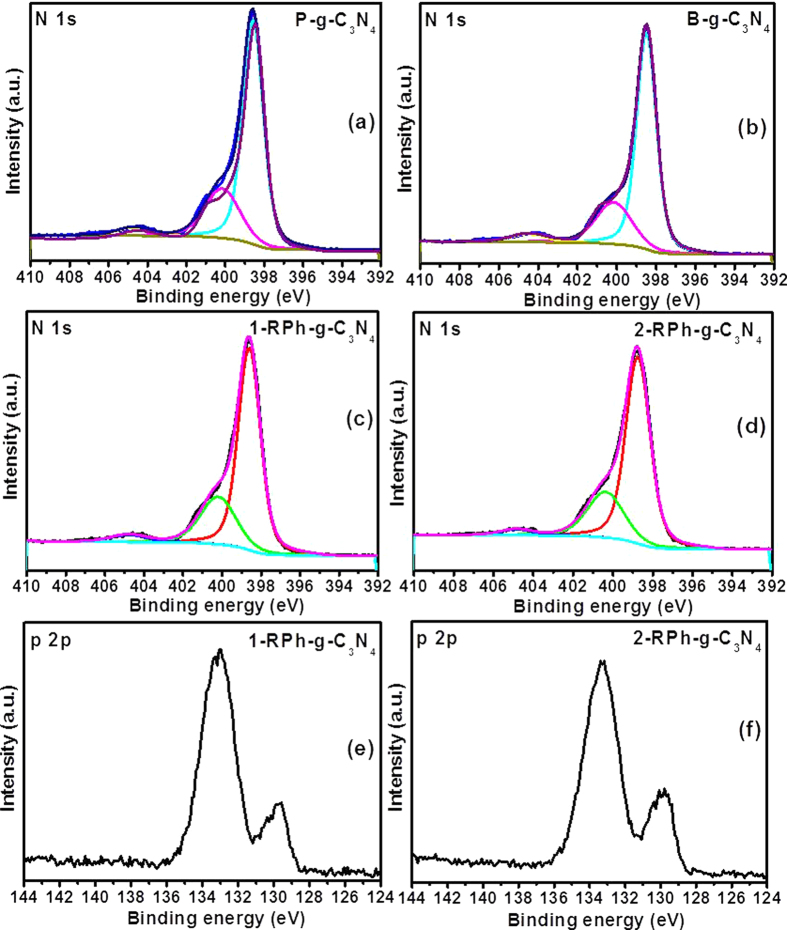
High resolution N 1s core level spectra of (a) P-g-C3N4, (b) B-g-C3N4, (c) 1-RPh-g-C3N4, (d) 2-RPh-g-C3N4 heterostructure, whereas (e) is the P 2p core level spectra of 1-RPh-g-C3N4 and (f) 2-RPh-g-C3N4 heterostructure.